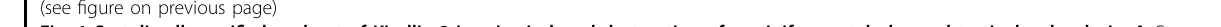
Fig. 1 Sertoli cell-speci fi c knockout of Kindlin-2 in mice induced destruction of seminiferous tubules and testicular dysplasia. A Gross morphology of testes from WT (refers to Kindlin-2 f/f ) and KO (refers to Amh-Cre ; Kindlin-2 f/f ) mice at 2 – 12 W. Compared to the WT mice, the size of KO testes is dramatically decreased. Scale bar, 5 mm. B Quanti fi cation of bilateral testes for mice (mean ± S.D. and n = 6). The variance was similar between the groups that are being statistically compared. Statistical analyses were performed using Student ’ s t-test at indicated time point. The variance was similar between the groups. * p < 0.05, ** p < 0.01, *** p < 0.001. C Hematoxylin and eosin-staining (HE) and immunohistochemistry (IHC) of Kindlin-2, WT1 (Sertoli cell nucleus marker) and StAR (Leydig cell marker) in 4 W testes. Scale bar, 50 μ m. Red arrows indicate the Sertoli cells, red and blank broken lines indicate the testicular tubular lumina. D Immuno fl uorescence of α -Tubulin (green) and laminin (red) in 4 W testes of WT and KO mice. The basement membrane of KO mice was thickener than that of WT mice (white arrow heads) Scale bar, 50 μ m. E Transmission electron microscopy (TEM) of 8 W testes. SC means Sertoli cell, GC means germinal cell, BM means basement membrane. Scale bar, 2 μ m. Red arrows: tight junction in WT testes and a large gap with only a loose cell junction between adjacent SCs in KO testes. Blue arrows: vacuoles located between adjacent SCs in KO